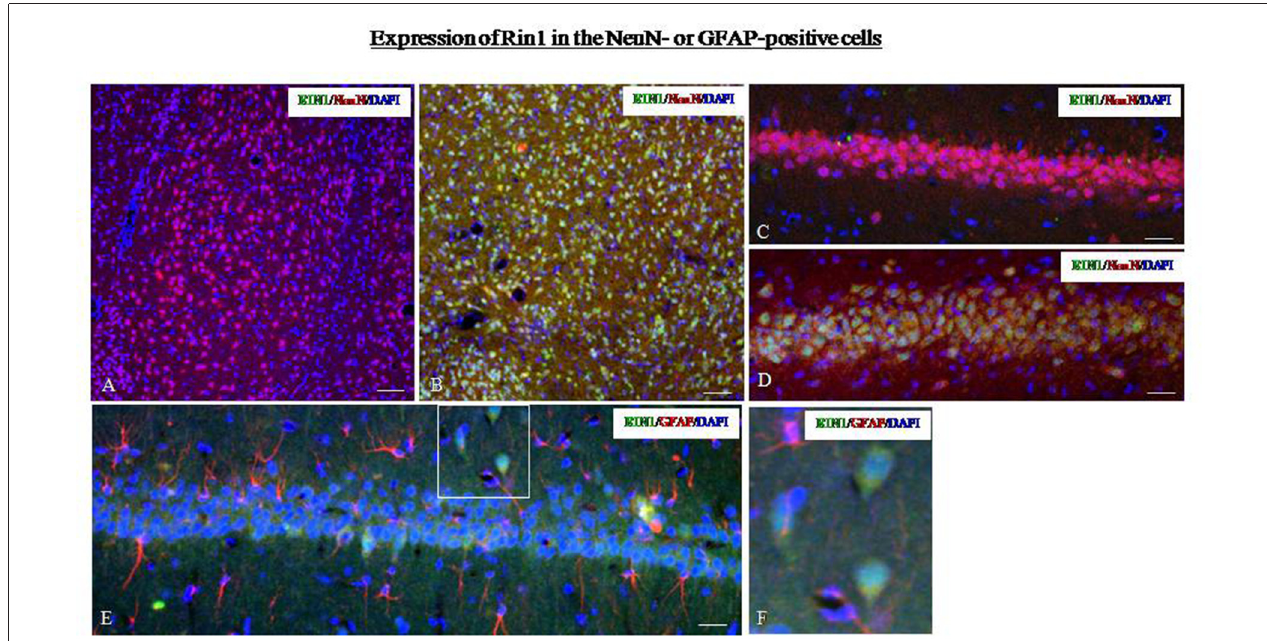
FIGURE 6 | (A,B) Dual-immunofluorescence images for Rin1-ir and NeuN-ir in the amygdala of the control (A) and SPS (B) groups. (C,D) Dual-immunofluorescence images for Rin1-ir and NeuN-ir in the hippocampus of the control (C) and SPS (D) groups. (E) Rin1-ir in GFAP-positive cells in the hippocampus of SPS rats. (F) A higher magnification image of the area in the white box in panel (E) (Bar in A,B : 100 µ m; Bar in C–E : 50 µ m).